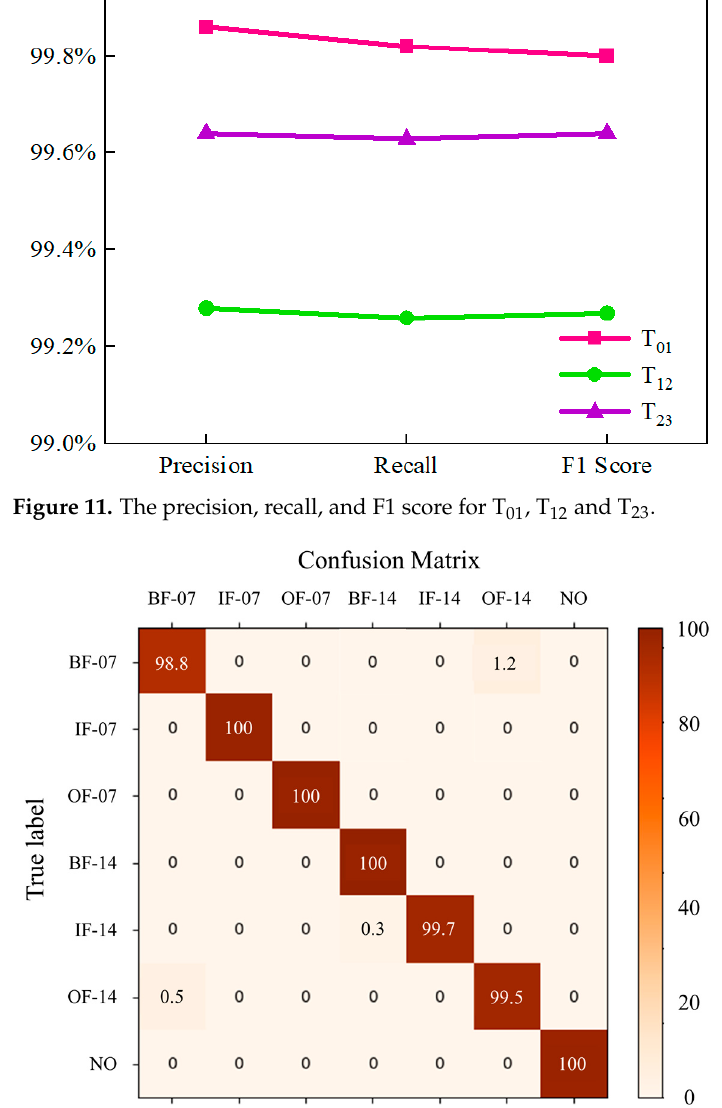
Figure 12. Confusion matrix of fault detection results.